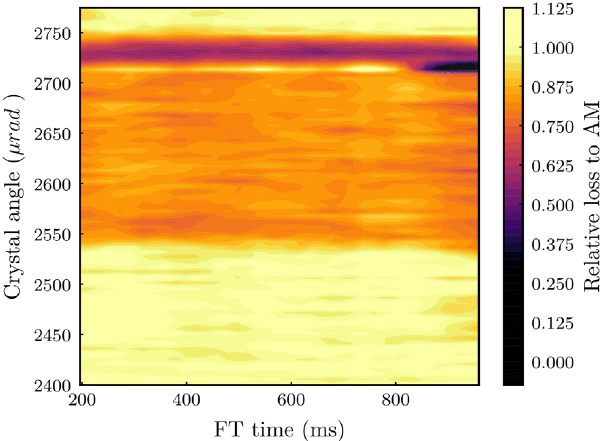
FIG. 20. Time evolution of the loss reduction at the ES measured on the SPS BLM system plotted during the angular scan presented in Fig.